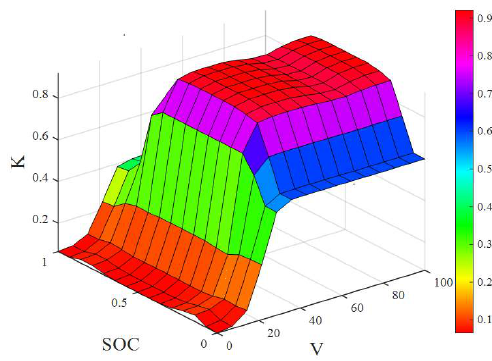
Figure 13. Relationship between K , V, and SOC .